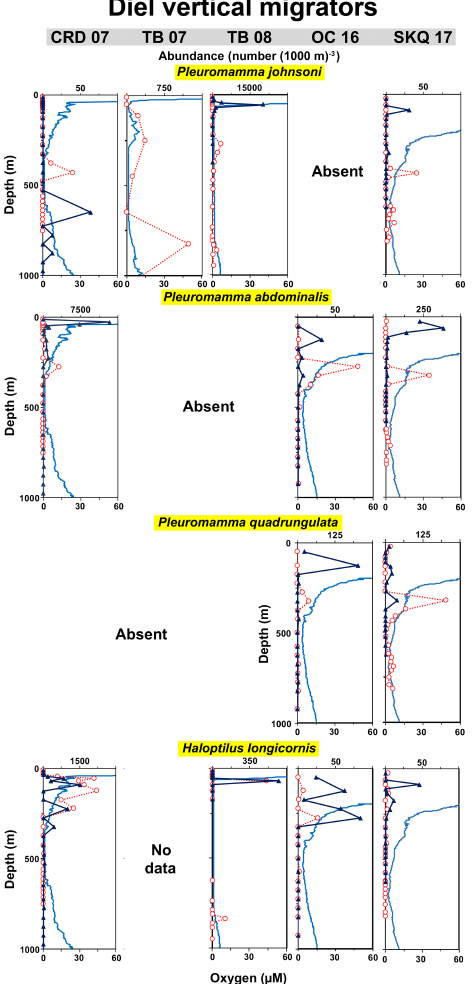
Figure 9. Vertical distributions relative to oxygen: diel vertical mi- grators. Each row is a different species. For the Pleuromamma species, which were searched for and identified in all tows, miss- ing figures represent locations with zero